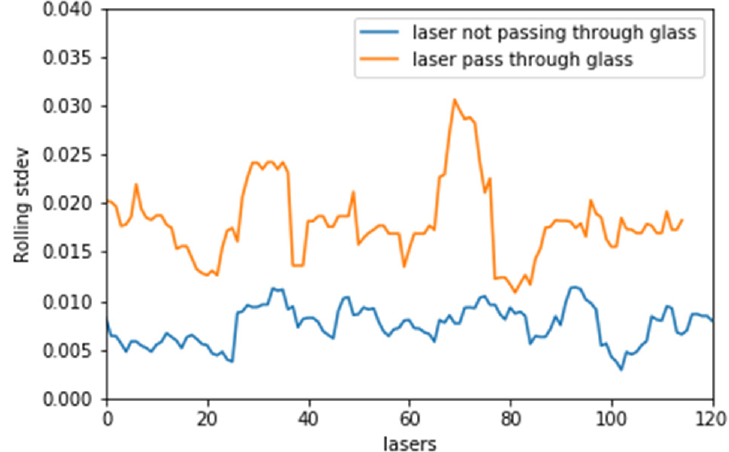
Figure 8. Rolling standard deviation (calculated using rolling window i.e., the standard devation of each window) of the laser range between point clouds passing through glass and point clouds directly hitting an object.